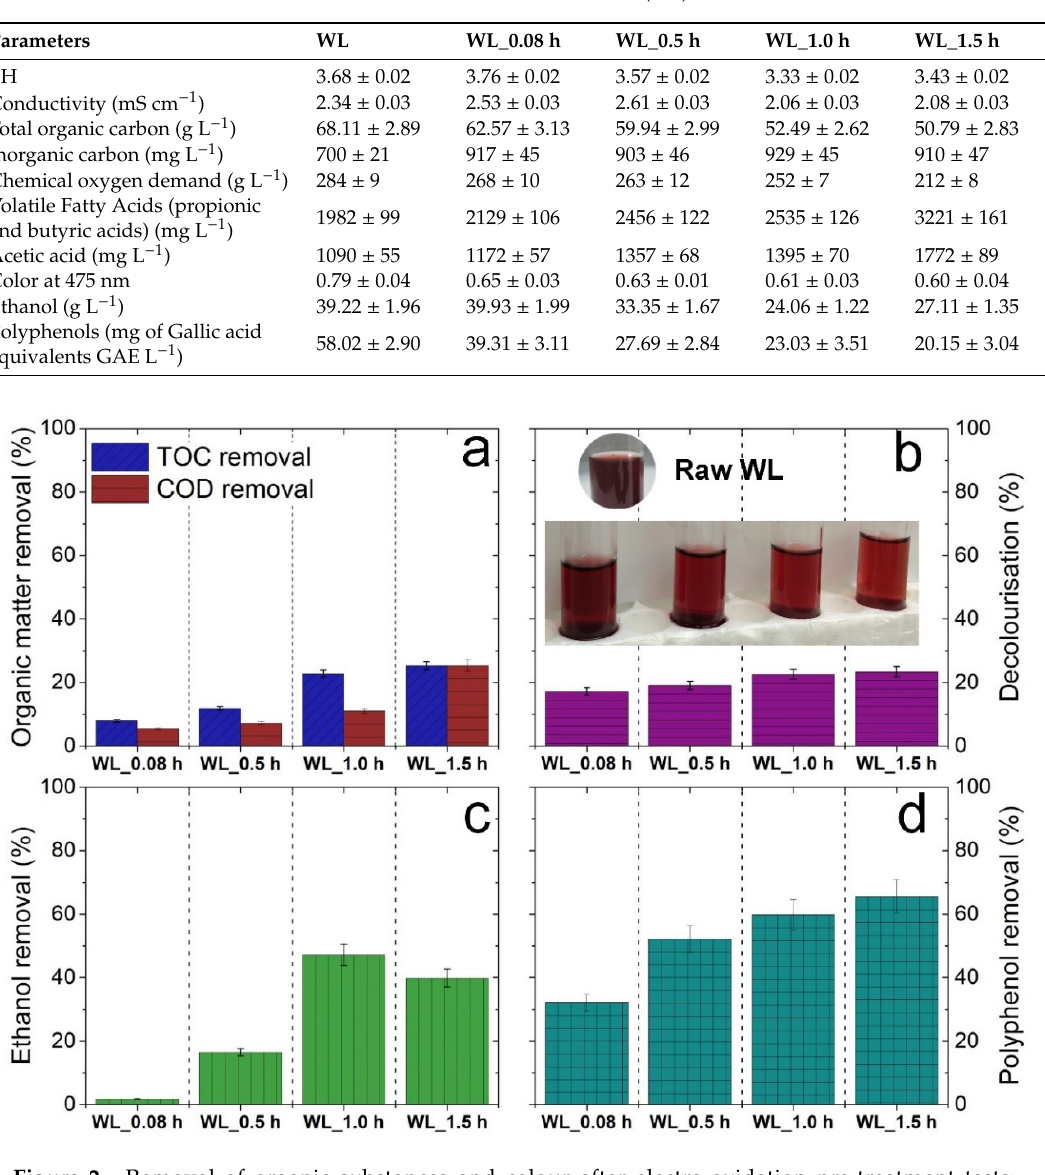
Figure 2. Removal of organic substances and colour after electro-oxidation pre-treatment tests: ( a ) Chemical oxygen demand (COD) and total organic carbon (TOC); ( b ) decolourisation at 475 nm; ( c ) ethanol; ( d ) total polyphenols. Table 4. Results of electro-oxidation (EO) tests.